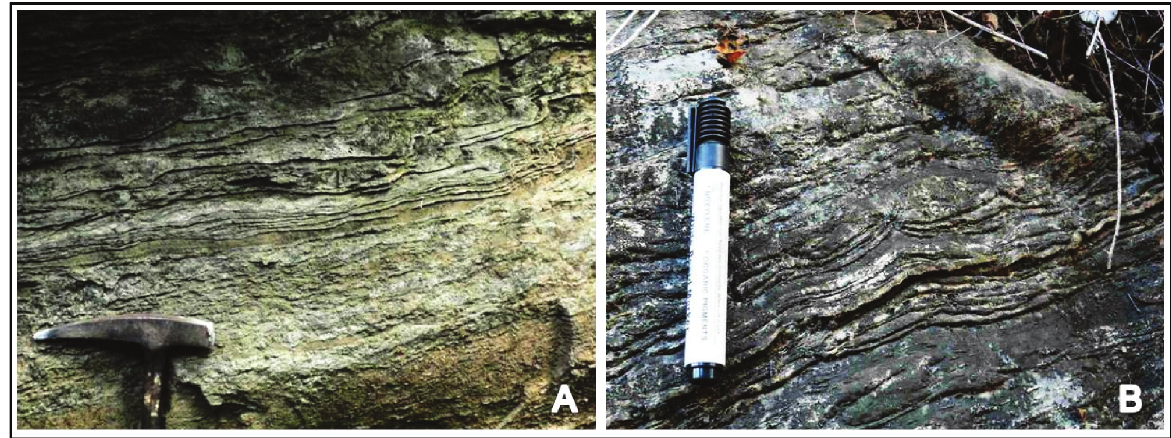
Figure 4 - Exposures of calcilutite and calcarenite at the Tijucuçu Farm showing plane-parallel lamination (A) and tepee structures (B)